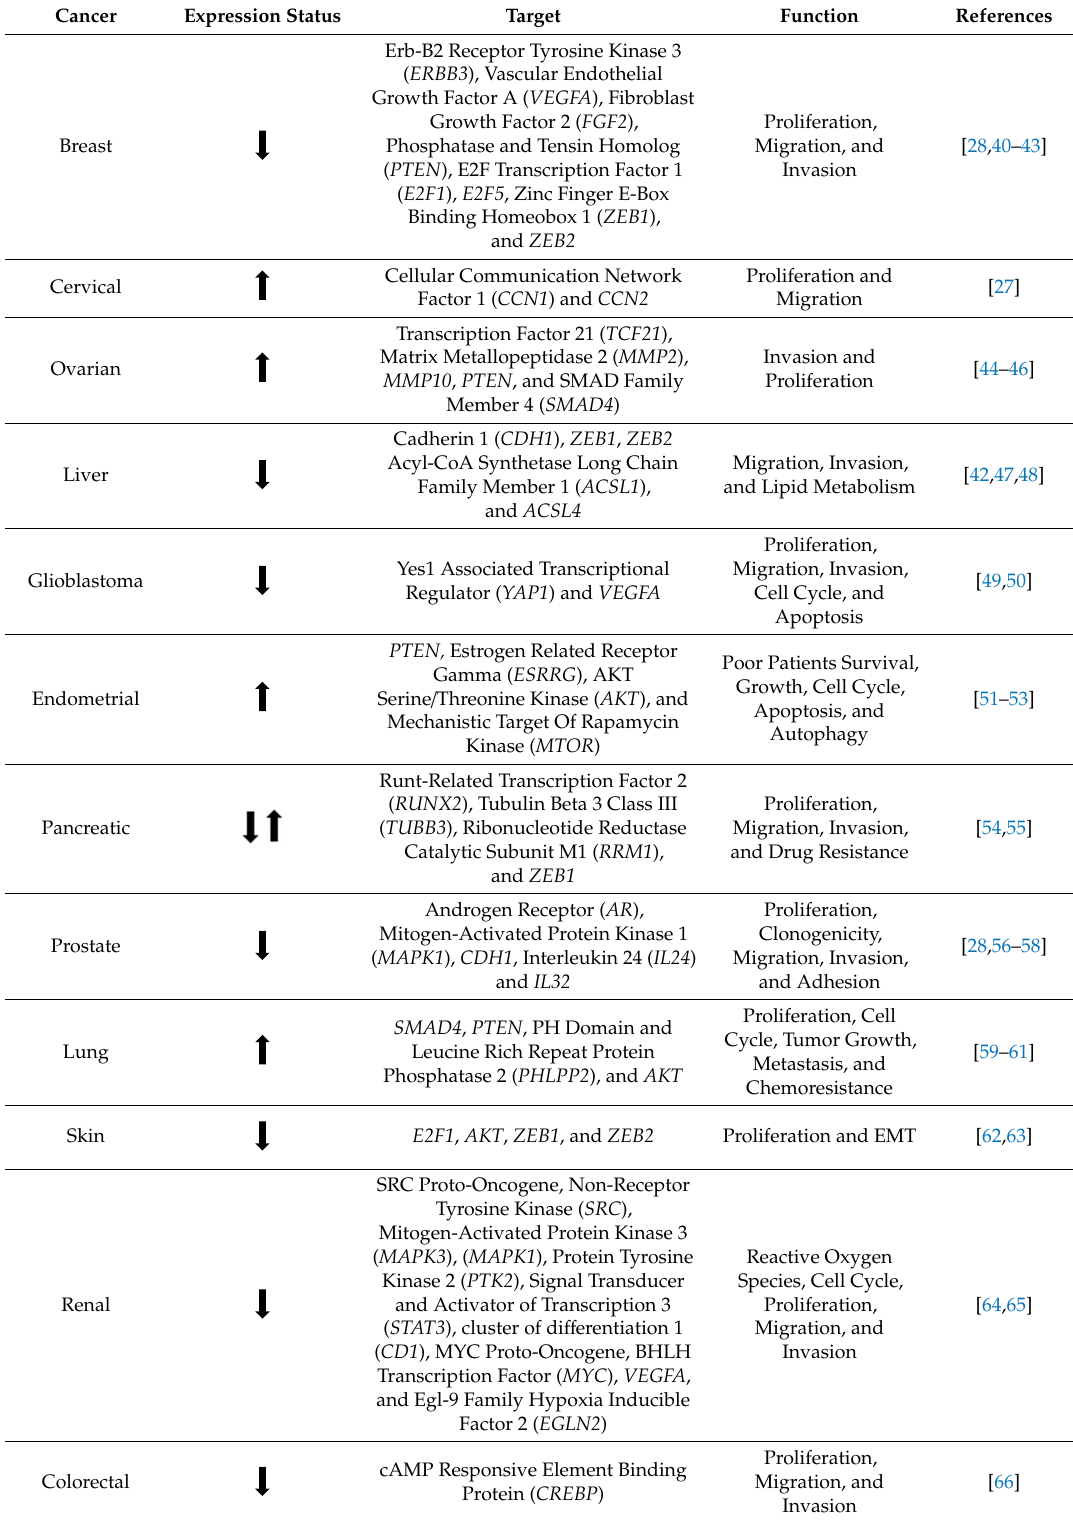
Table 1. Expression status, targeted genes, and resulted functions of miR-205 in different cancers in comparison with the corresponding normal tissue(s).